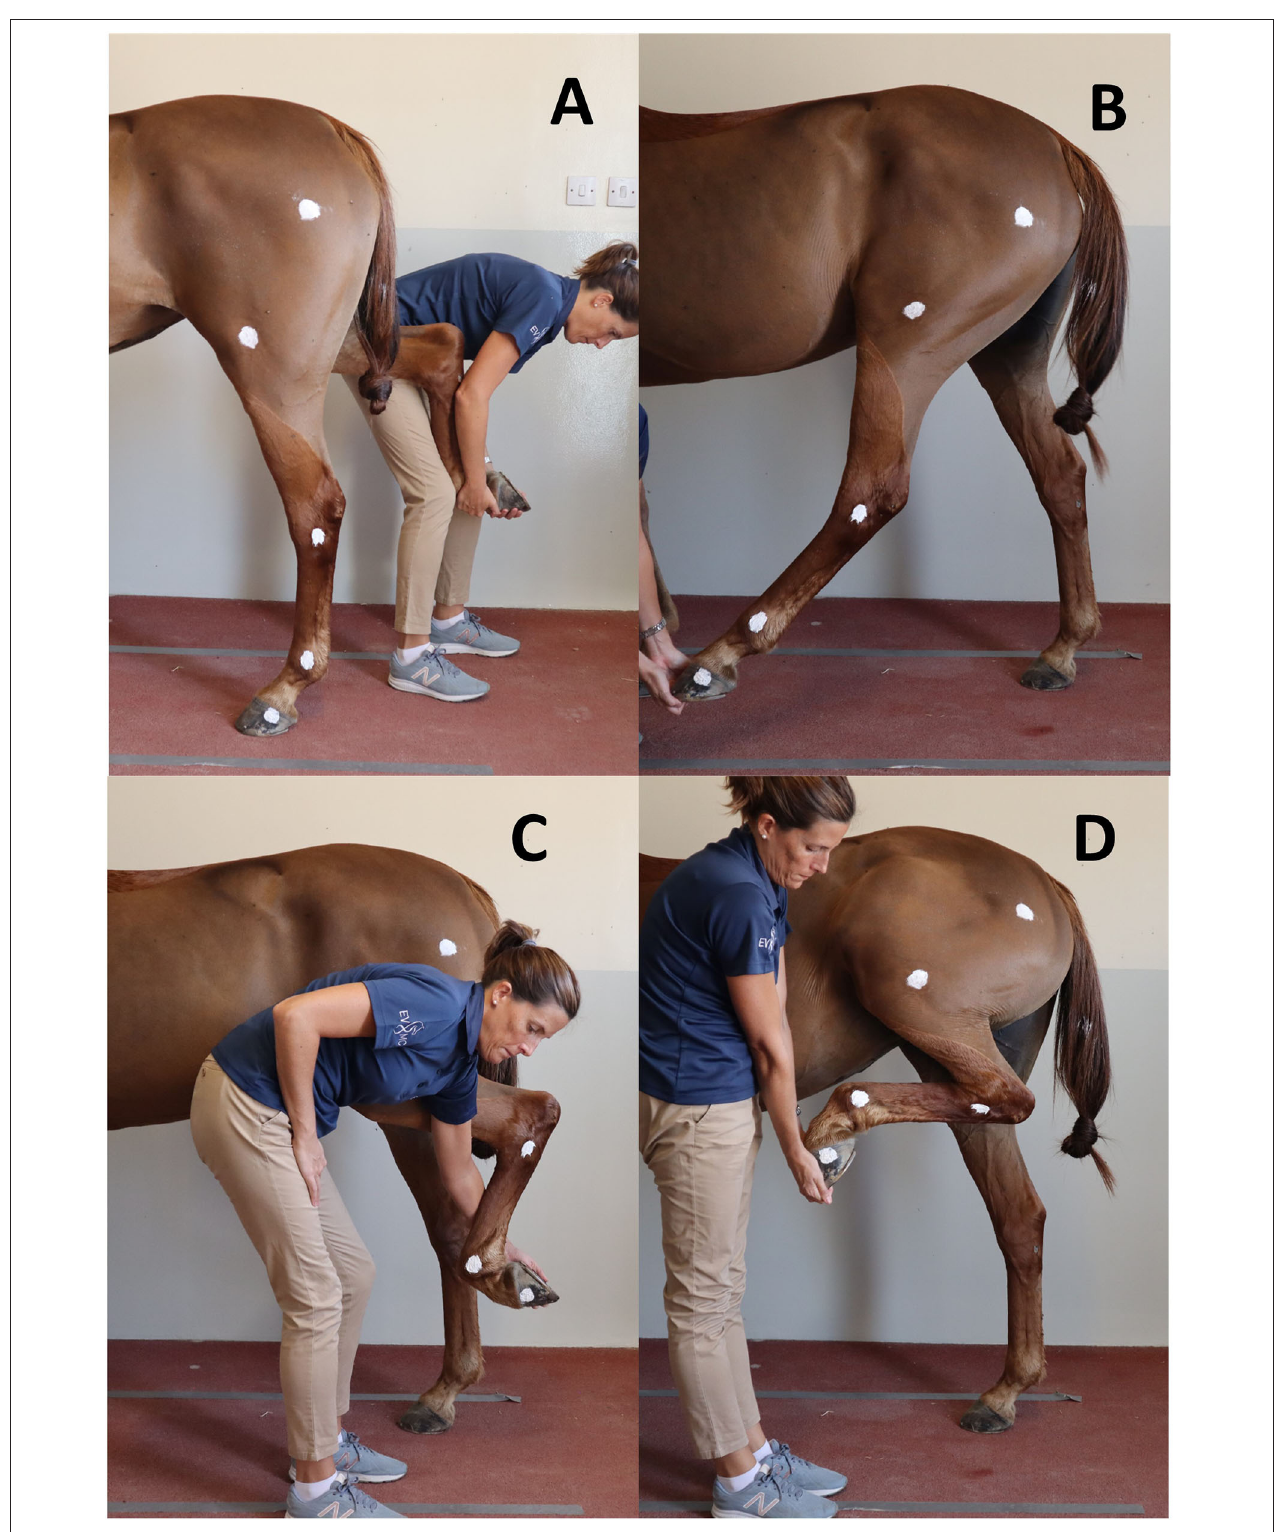
FIGURE 2 | Positions obtained for maximal flexion and extension of the hindleg during passive mobilization. (A) Maximal fetlock and tarsus extension; (B) Maximal stifle extension; (C) Maximal fetlock flexion; (D) Maximal tarsus and stifle flexion.